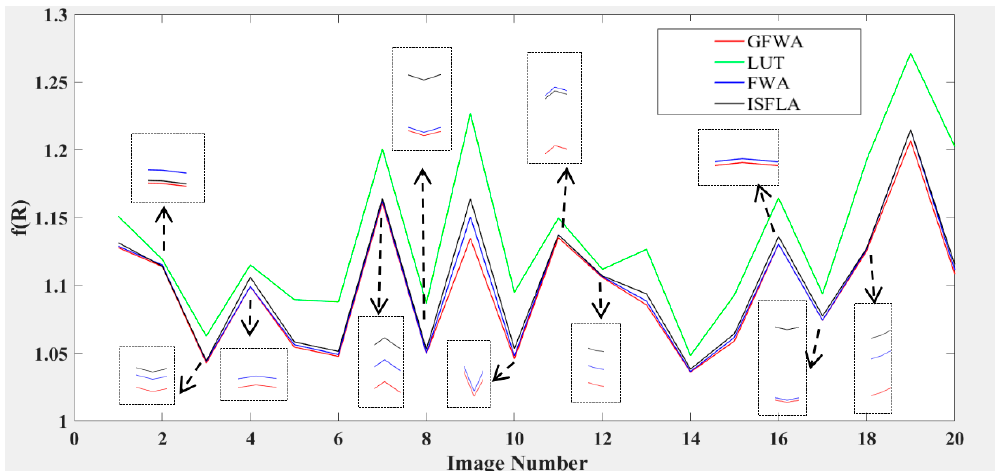
Figure 4. Comparison of the f (R) values of the four algorithms. LUT: Look-Up Table; ISFLA: Improved Shuffled Frog Leaping Algorithm.